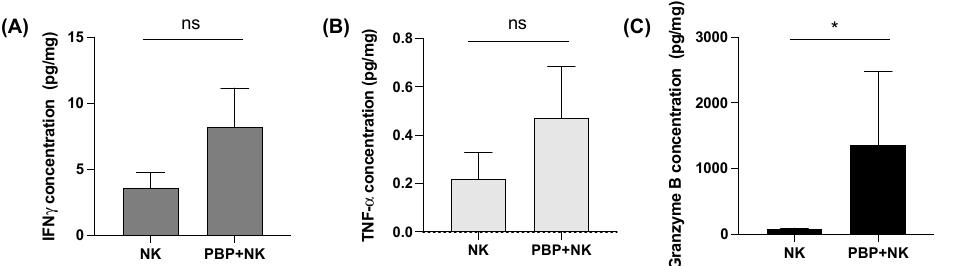
Figure 5. Cytokine levels determined by ELISA of tumor lysates: ( A ) IFN- γ , ( B ) TNF- α , and ( C ) Granzyme B. One-way ANOVA, Tukey test, p < 0.05 was performed for statistical analysis (* p < 0.03, and ns = non-significance).